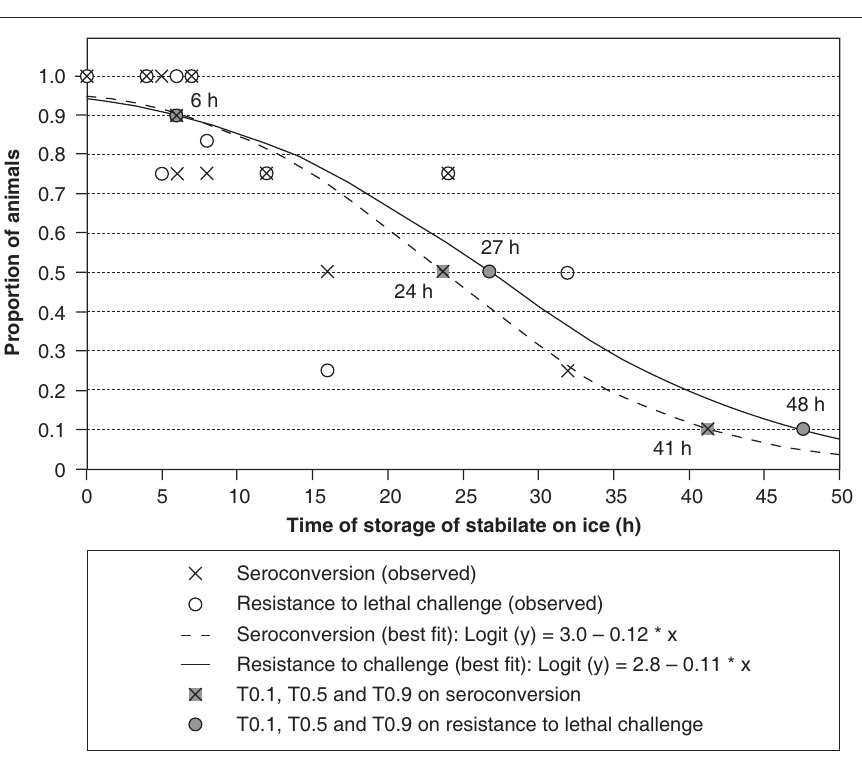
FIG. 1 Effect of storing Theileria parva stabilates on ice on the ability to induce immunity in cattle (Marcotty et al.